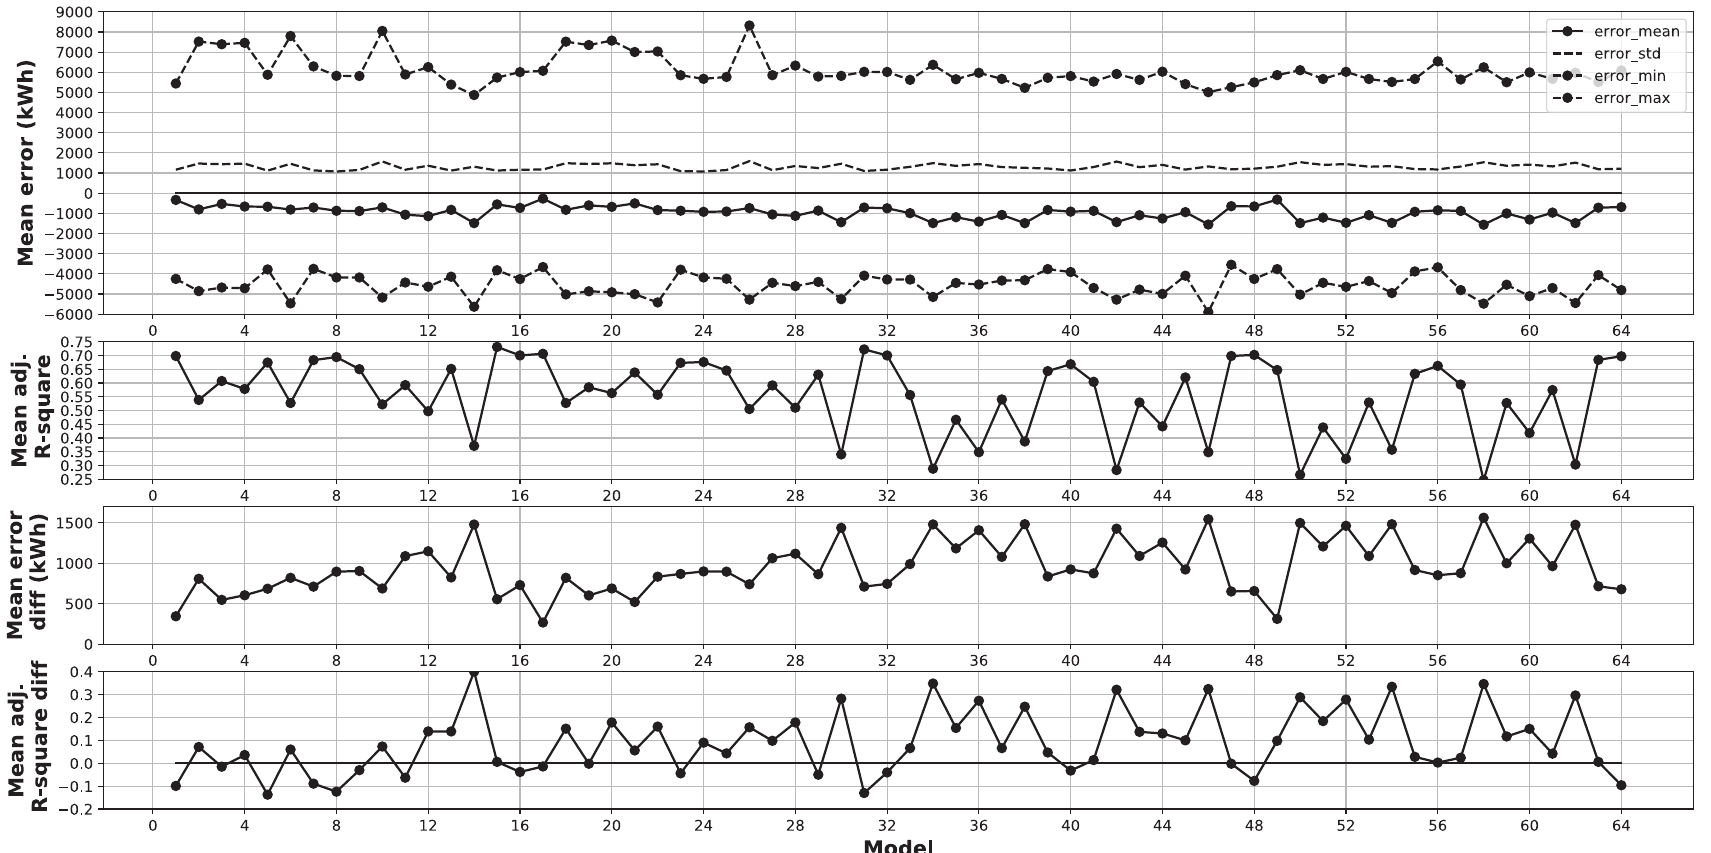
Figure A1. The modeling results from the domain approach. Top panels: Mean error plots for the best models of the 64 variable batches. The solid line with circles, ∆ ∆ ∆ ∆ max , respectively. The solid line represents zero error and is used as reference for µ . The dashed line without circles, σ . The dashed lines with circles, min and clarity purposes. The ¯ R 2 µ of each model. The model with the highest ¯ R 2 µ is model 15 with ¯ R 2 µ = 0.731. Bottom panels: The difference in ∆ µ and ¯ R 2 µ between the training and the test